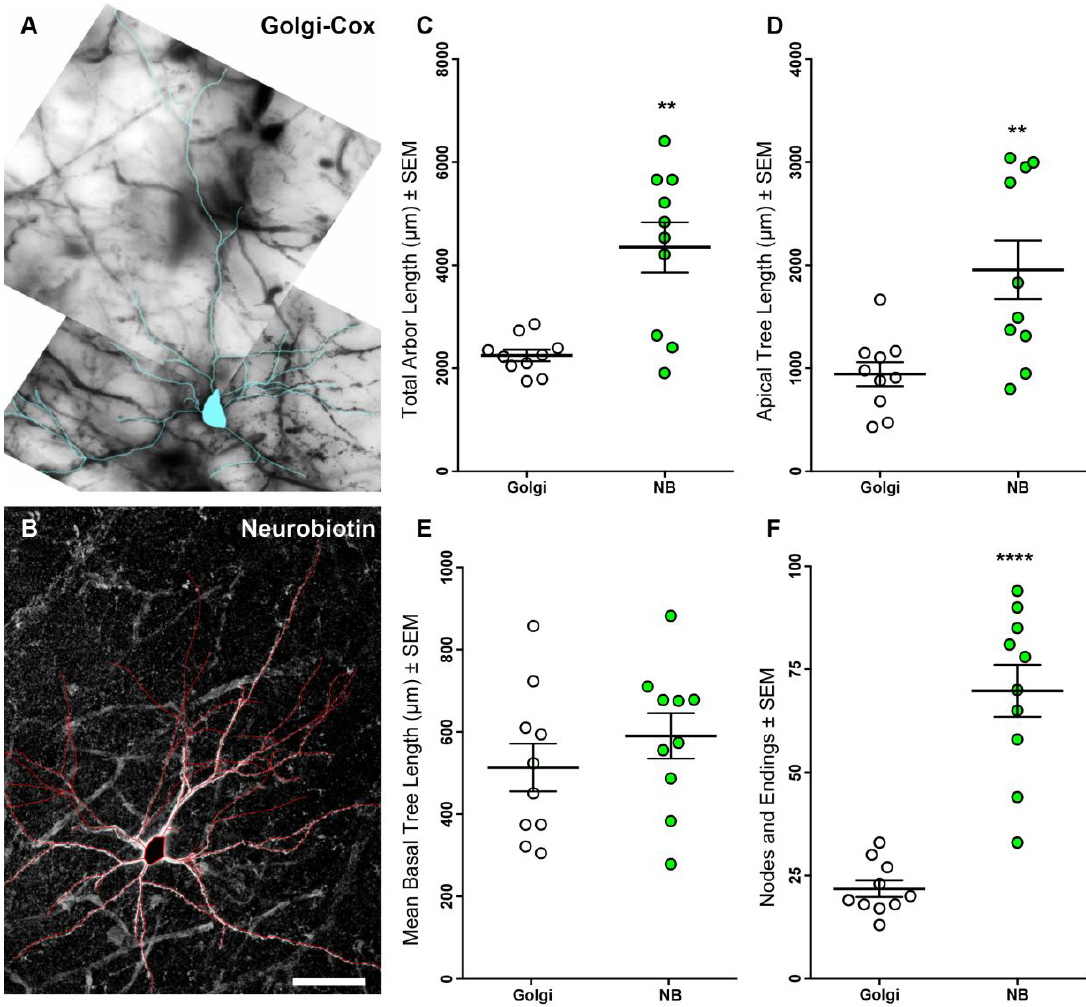
Figure 1. Basolateral amygdala (BLA) principal neuron dendritic arbors from Golgi–Cox and neurobiotin (NB)-filled methods. ( A ) shows a Golgi–Cox impregnated BLA principal neuron with the arbor identified using a magenta overlay; ( B ) shows a NB-filled BLA principal neuron with arbor identified using a red overlay; ( C – F ) show scatterplots of increased total dendritic arbor length, increased apical arbor length, unchanged mean basal tree length and increased dendritic nodes and endings in NB-filled (green circles) neurons compared to Golgi–Cox impregnated neurons (open